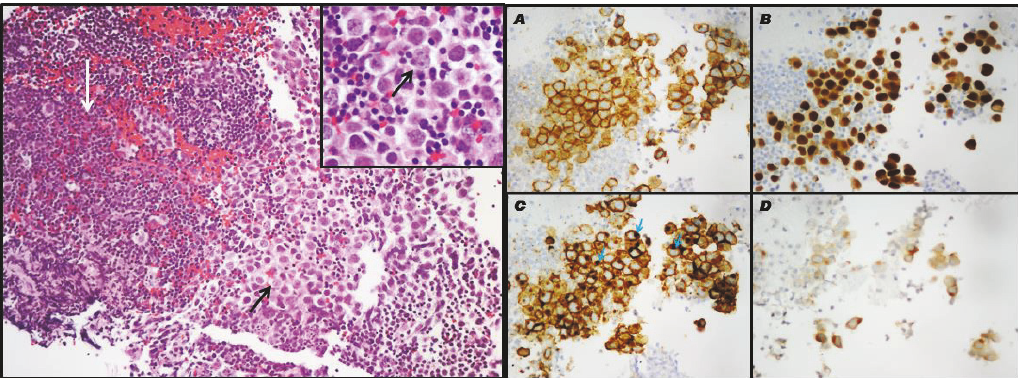
Figure 2: Germinoma (left): large round germ cells (black arrows) within a background of lymphocytes (white arrow); H&E 200x, insert showing H&E 400x (right). A: C-kit (CD117) stains the membranes of neoplastic cells (400x). B: OCT-4 producing strong nuclear staining (400x). C: PLAP staining the membranes and the Golgi apparatus, blue arrows (400x). D: B-hCG staining isolated syncytiotrophoblastic cells (400x). B-hCG: human chorionic